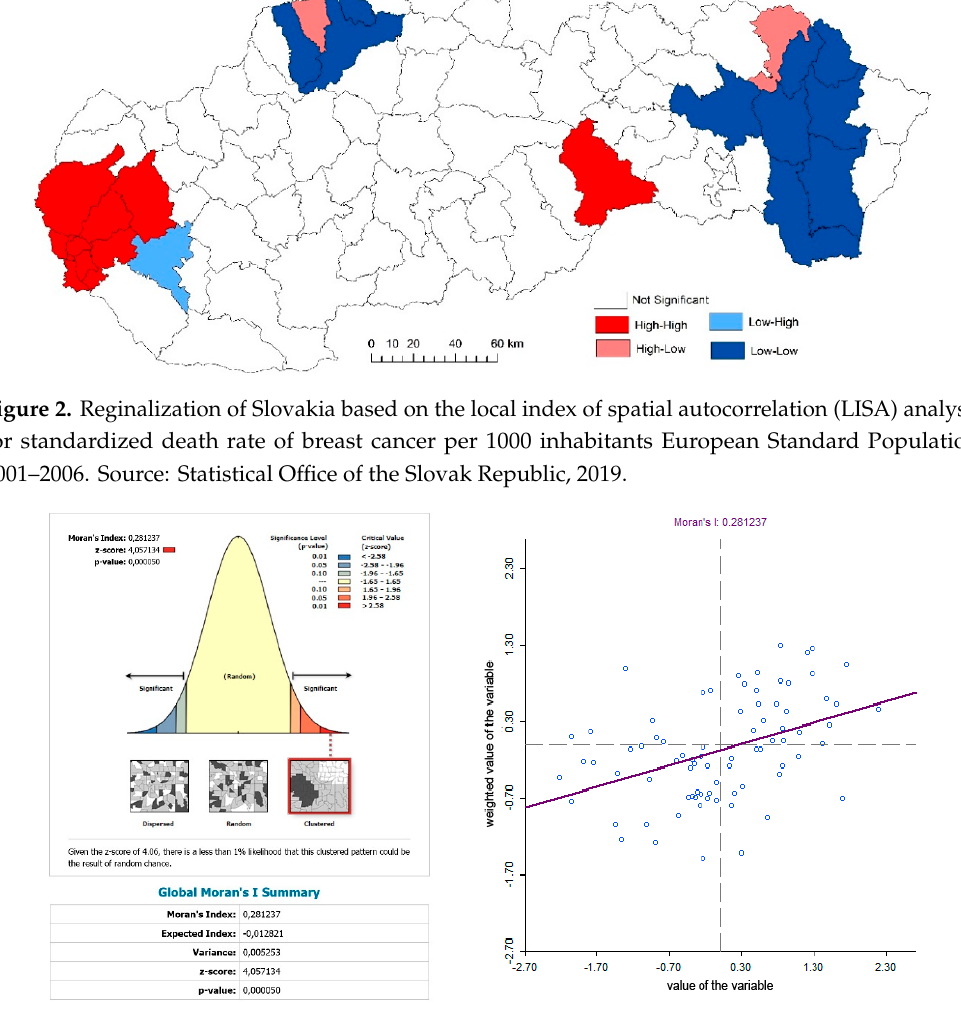
Figure 5. Final statistics and Moran ′ s diagram for standardized death rate of breast cancer per 1000 inhabitants of European Standard Population, 2007–2012. Source: Statistical Office of the Slovak Republic, 2019.